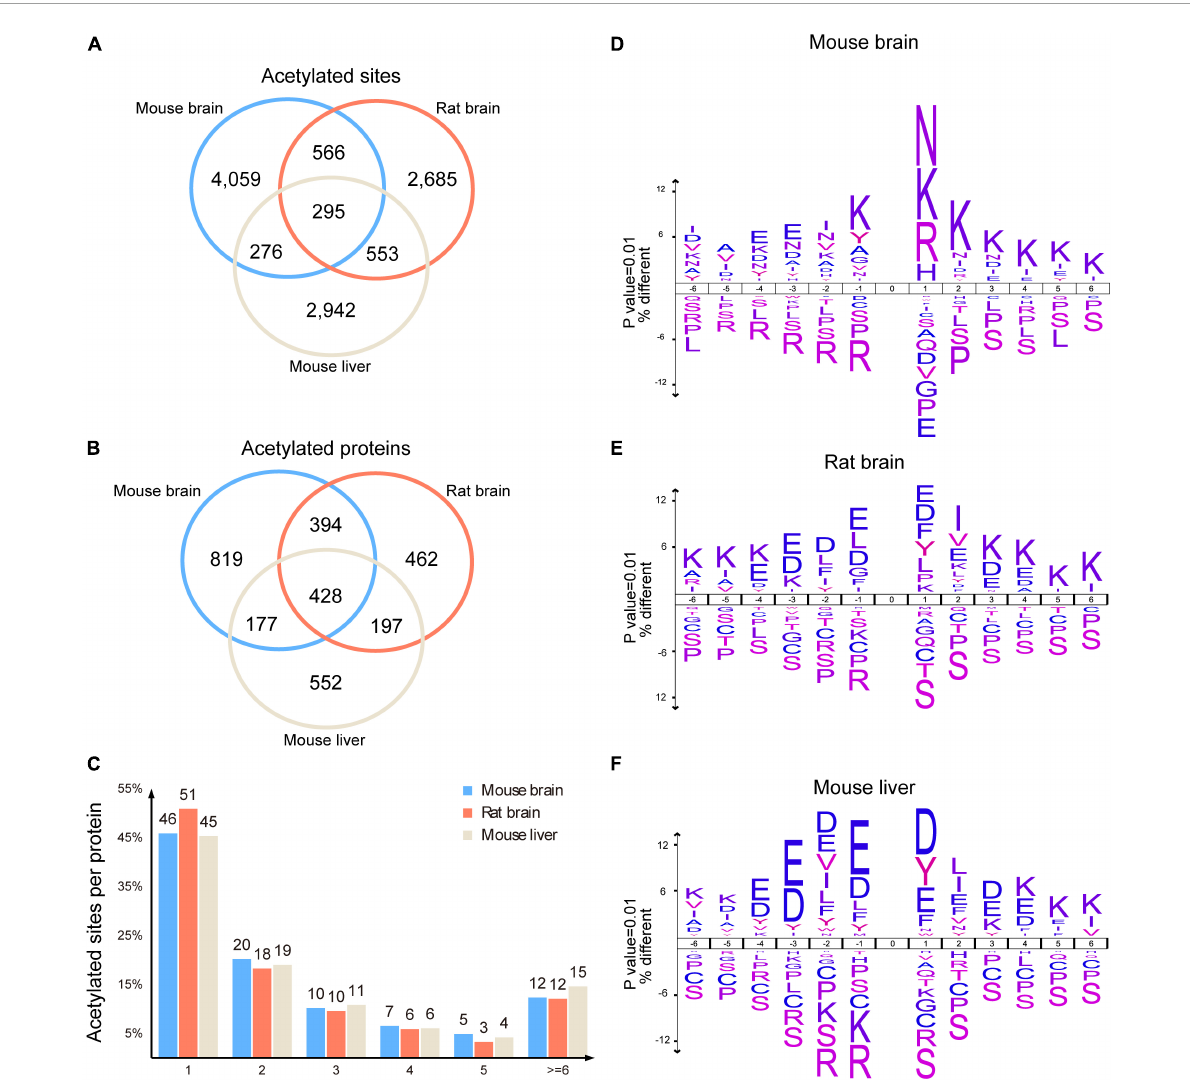
FIGURE4 Characteristics of the mouse brain acetylome. Venn diagram showed the shared acetylated sites (A) and proteins (B) among the acetylomes of the mouse brain, rat brain, and mouse liver. Histogram illustrating the number of acetylated sites per acetylated protein in the mouse brain, rat brain, and mouse liver (C) . Representations of the sequence preference flanking the acetylated lysine in the mouse brain (D) , rat brain (E) , and mouse liver (F) ( p < 0.01). The size of the letter indicated the frequency of the corresponding amino acid residue in that